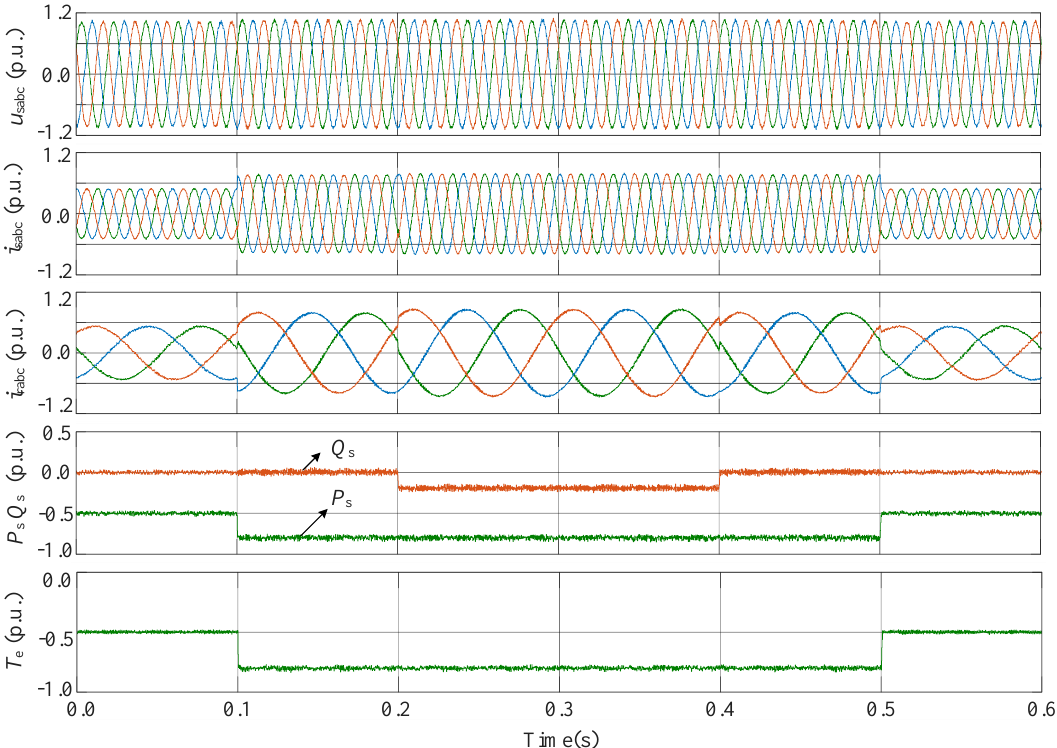
Figure 4. Simulation results during the power steps under balanced grid voltage conditions.